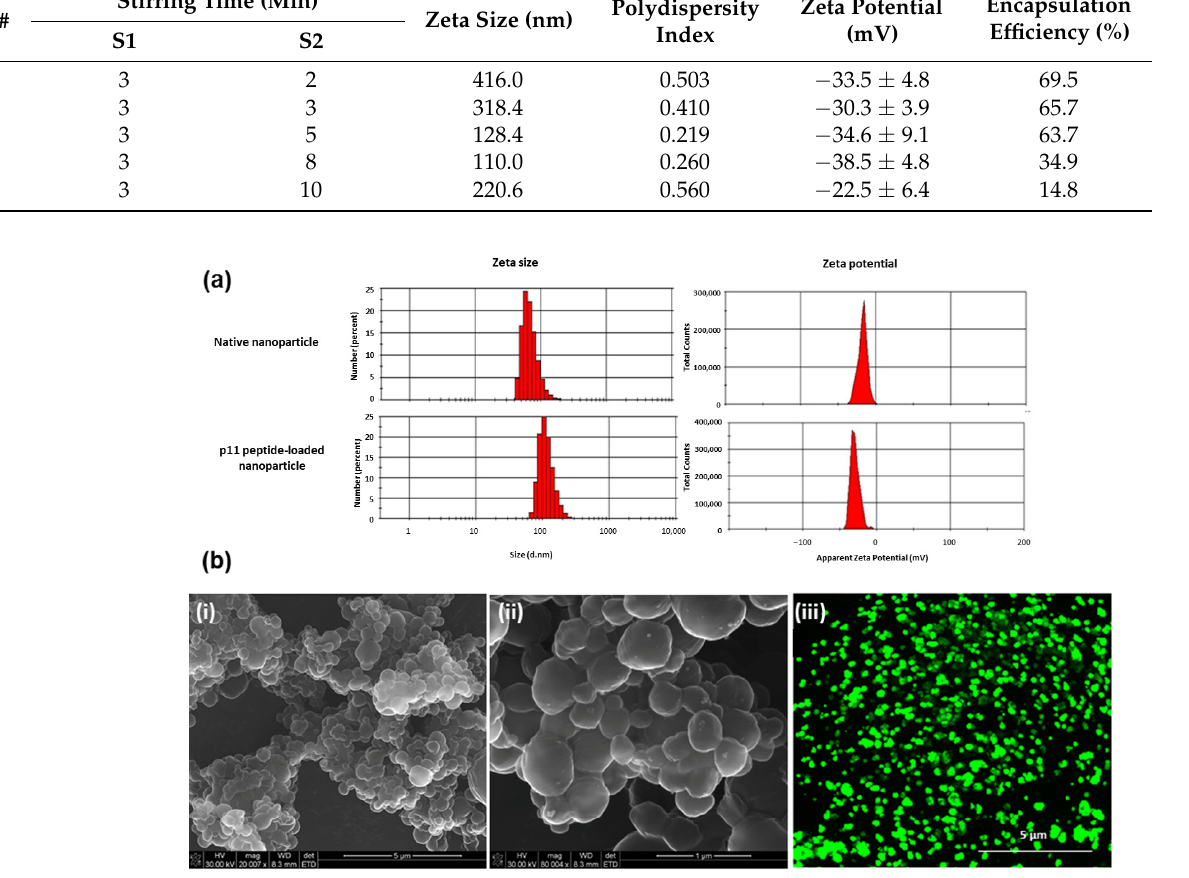
Figure 2. ( a ) Particle size and zeta potential analysis of the native and FITC-p11 peptide-encapsulated nanoparticles. ( b ) (i) SEM (scanning electron microscopy) image of nanoparticle. (ii) High magnifica- tion SEM image. (iii) Confocal microscopic image of the FITC-P11 peptide-encapsulated